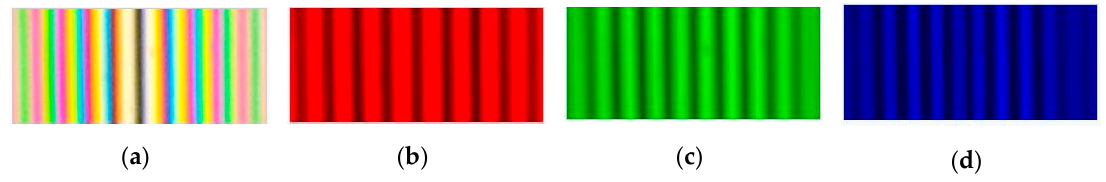
Figure 2. The interference pattern of white light and RGB light interference components. ( a ) White light interference pattern; ( b ) red light interference pattern; ( c ) green light interference pattern; ( d ) blue light interference pattern. Appl. Sci. 2019 , 9 , x FOR PEER REVIEW